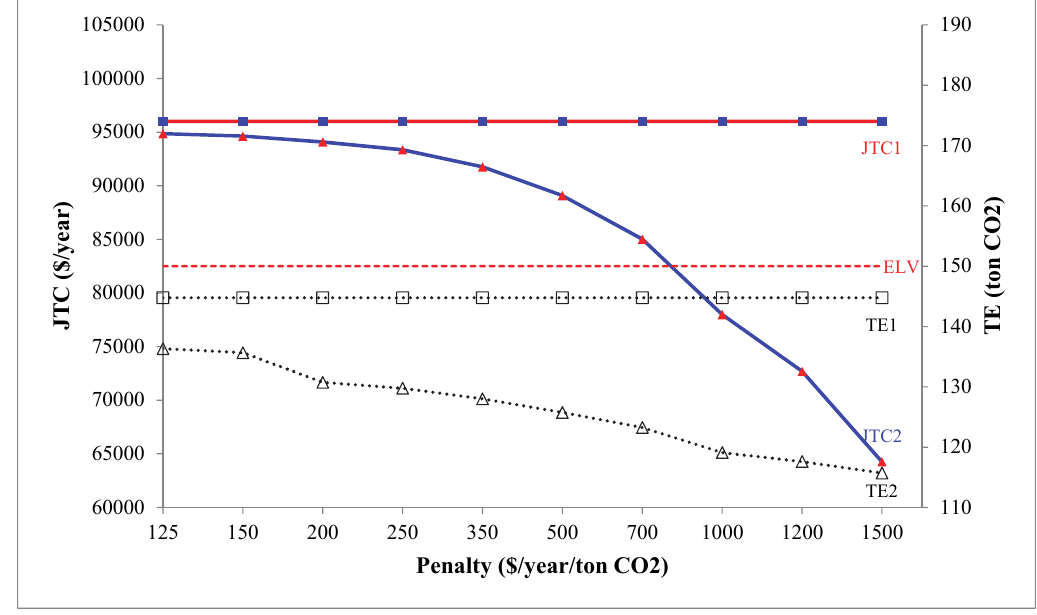
Fig. 4. The effect of changing in penalty on total cost and total emission